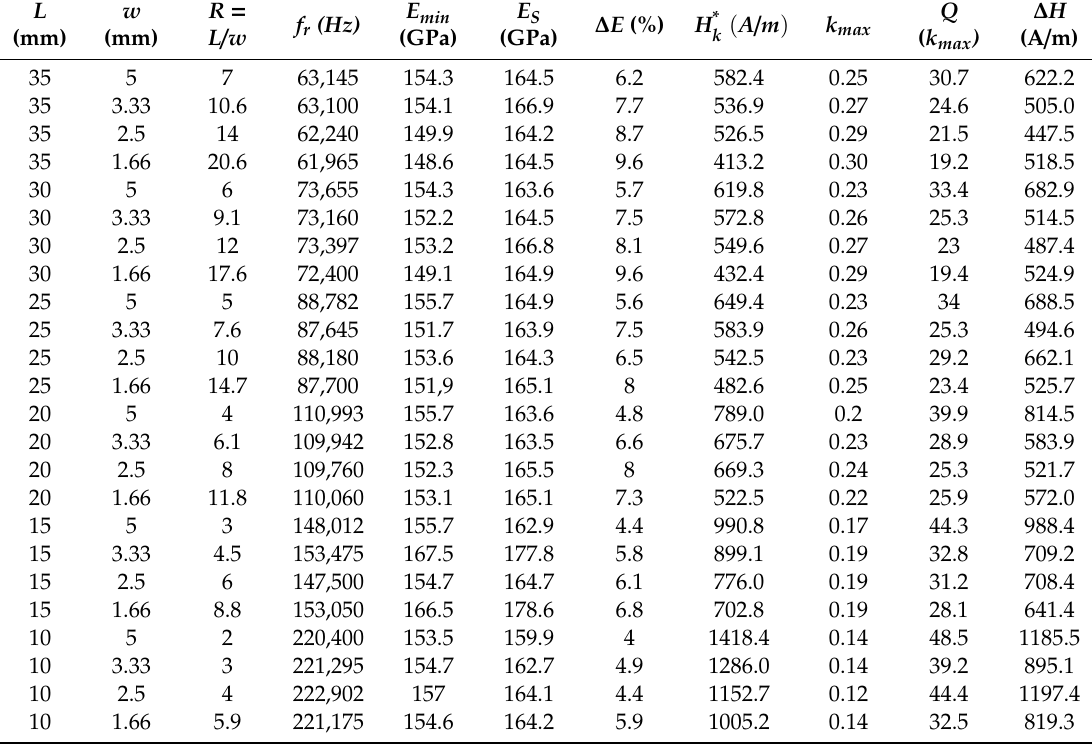
Figure 3. Δ E effect measured with: ( a ) L constant and variable w and ( b ) w constant and variable L . All the magnetoelastic parameters estimated from the measured E(H) and resonance / anti-resonance ® frequency measurements performed for all the studied Metglas 2826MB3 strips with di ff erent lengths L and di ff erent widths w are summarized in Table 1. Table 1. Magnetoelastic characterization values obtained from the resonance / anti-resonance frequency measurements.